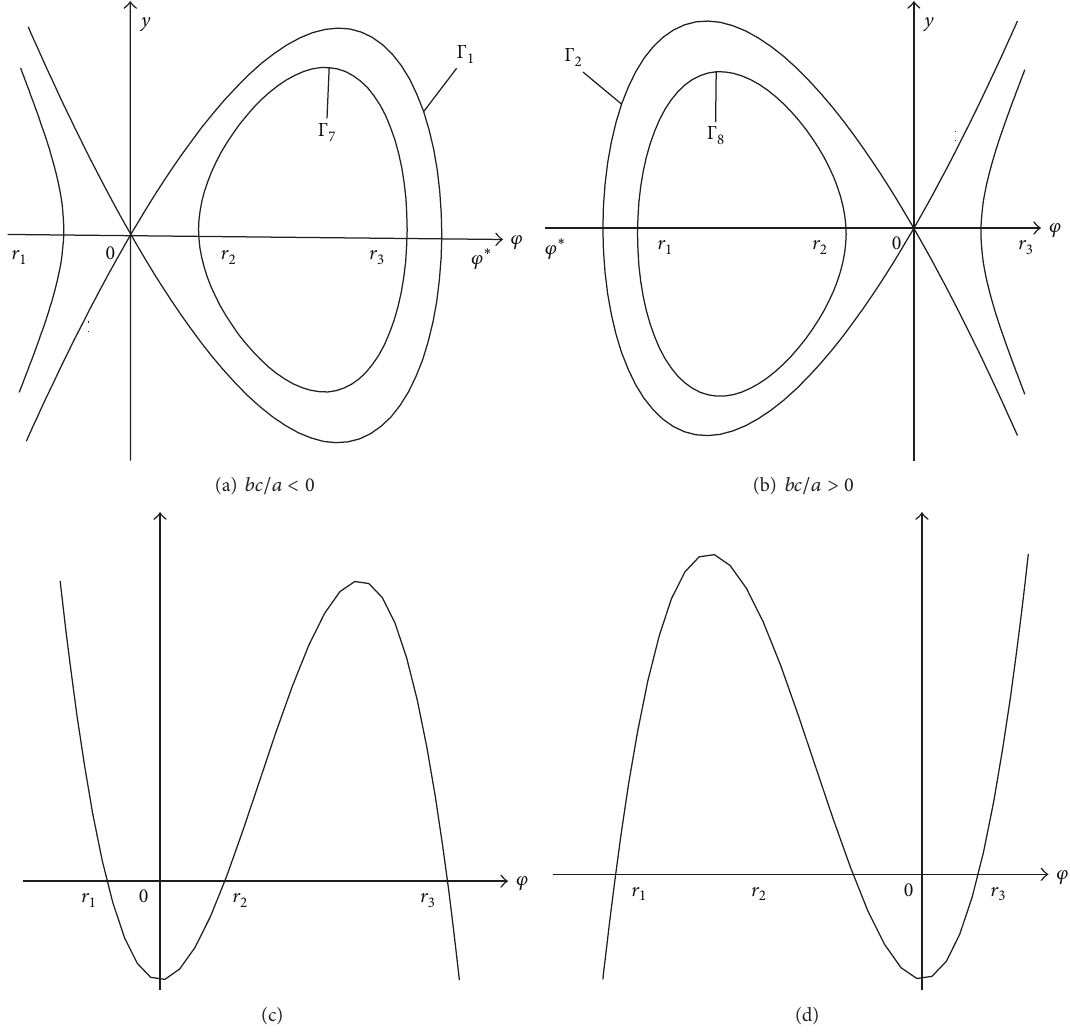
Figure 1: The bifurcation phase portraits of system (6) with 𝑔 = 0 and (1 + 𝑘𝑟 2 + 𝑐)/𝑏𝑐 < 0